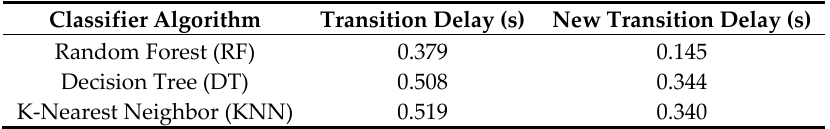
Table 4. Transition delays for